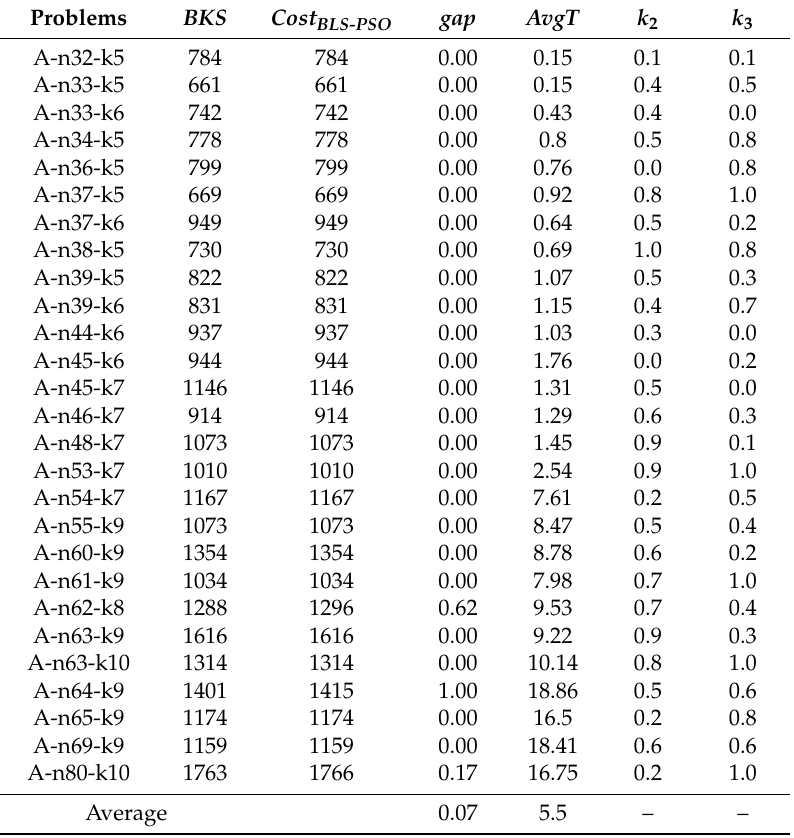
Table 4. Performance of BLS-PSO in solving the benchmark problems in Set A.